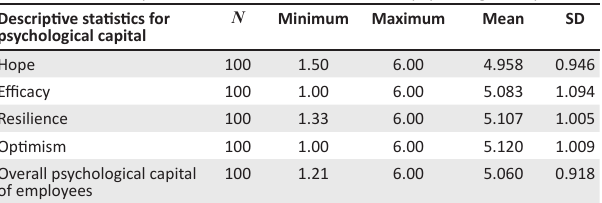
TABLE 15: Summary statistics of the four constructs of psychological capital. Descriptive statistics for psychological capital